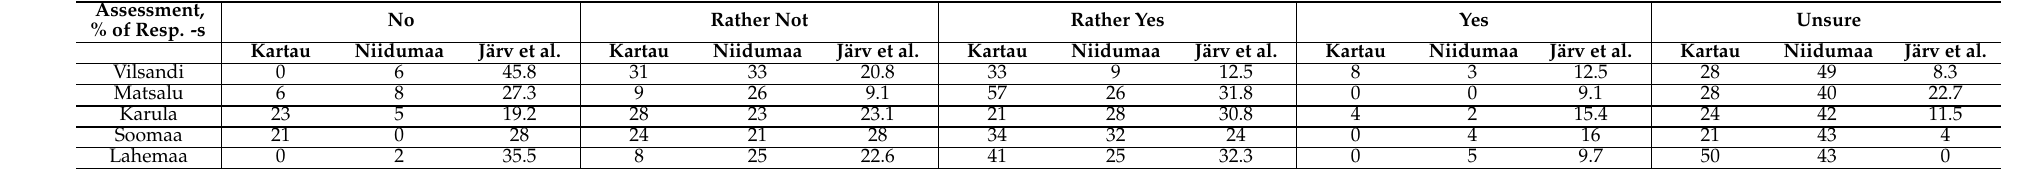
Table 5. Willingness to pay for nature conservation in home region, results by park (Kartau, 1998; Niidumaa, 2009; Järv et al., 2021). Assessment, % of Resp.